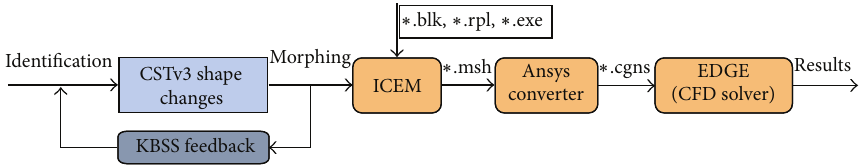
Figure 4: The implemented procedure for 2D CFD analyses embedded into the CST class.